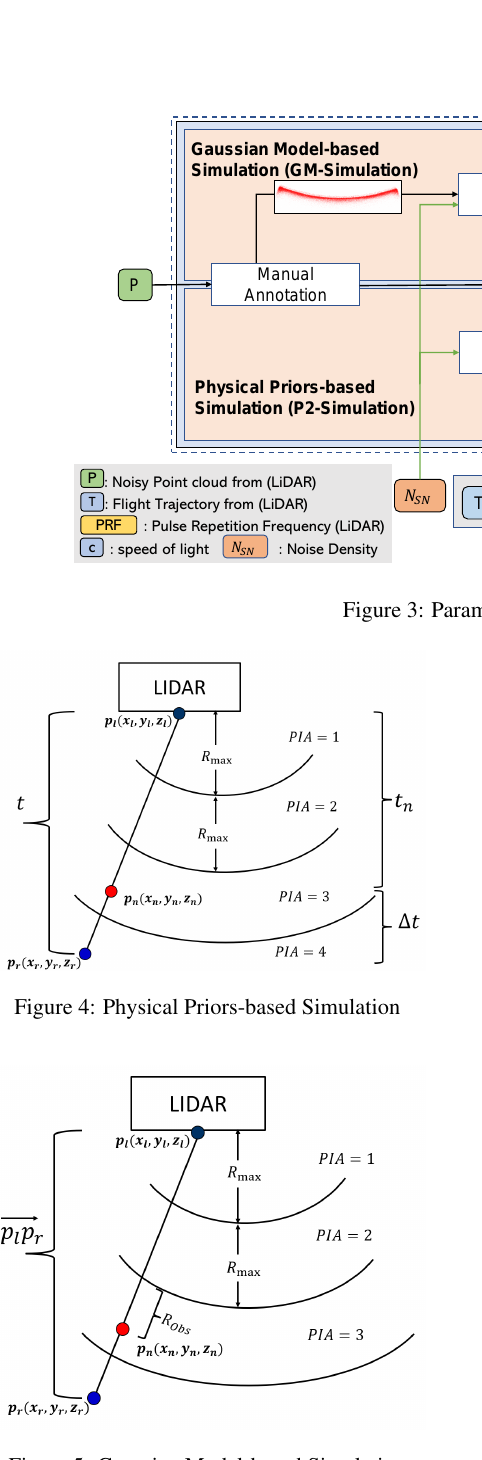
Figure 5: Gaussian Model-based Simulation to 0.1% to 3.5% presence of noise, each scene has imbalanced class distribution.